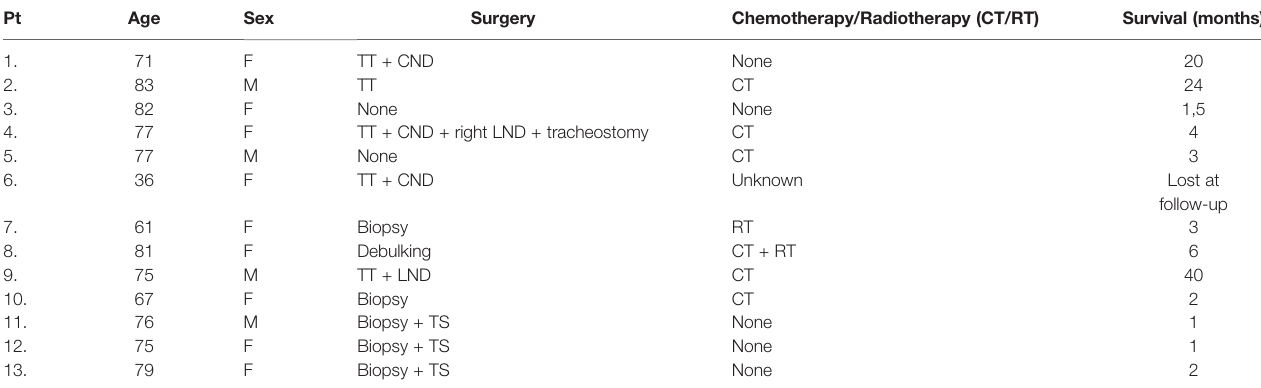
TABLE 1 | Pt, patient; TT, total thyroidectomy; CND, central neck dissection; LND, lateral neck dissection; TS, tracheal stent; CT, chemotherapy; RT,